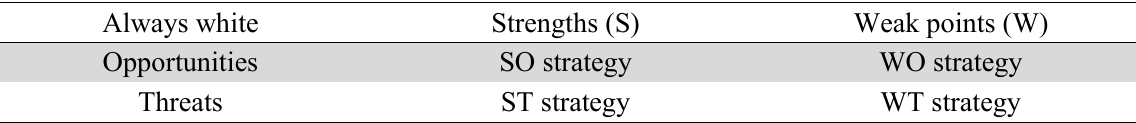
SWOT matrix Always white Strengths (S) Weak points (W) Opportunities SO strategy WO strategy Threats ST strategy WT